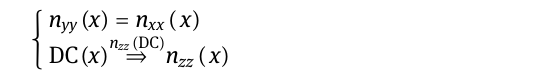
xx and n zz asfunctionthe